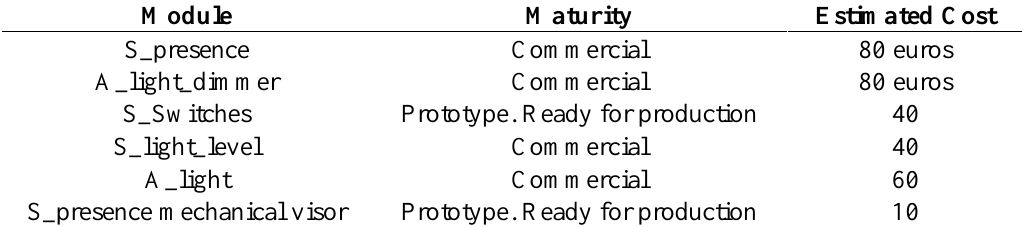
Table 11. Analysis of maturity and cost of each module.